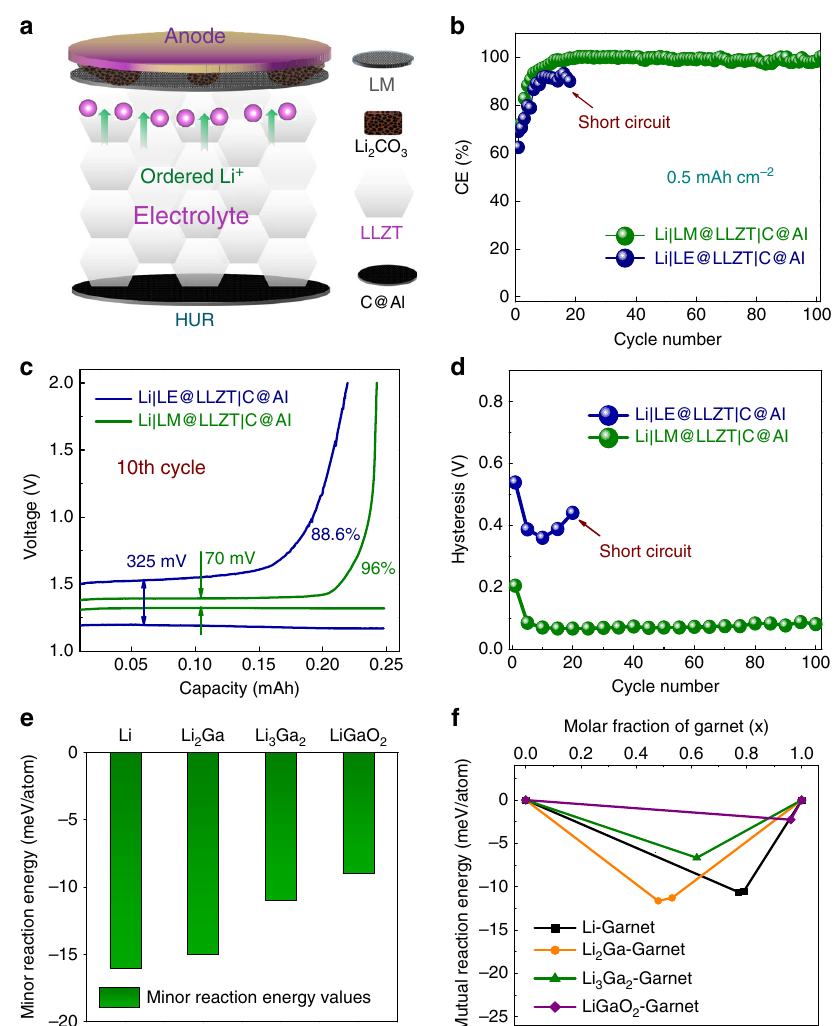
Fig. 5 Electrochemistry of asymmetric cells and interface stability evaluation. a Schematic of ordered Li + fl ux across LM-modi fi ed interface, leading to high utilization ratio (HUR) of Li anode. b CE values of Li|LM@LLZT|C@Al and Li|LE-LLZT|C@Al asymmetric cells with carbon-coated allium foil as counter electrode as a function of cycle number at 0.1 mA cm − 2 . c Voltage pro fi les of both the asymmetric cells at the 10th cycle. d Comparison of voltage hysteresis evolution of both the asymmetric cells within 100 cycles. Calculated ( e ) minor reaction energies and ( f ) mutual reaction energies between main interface phases (after lithiation) and garnet solid